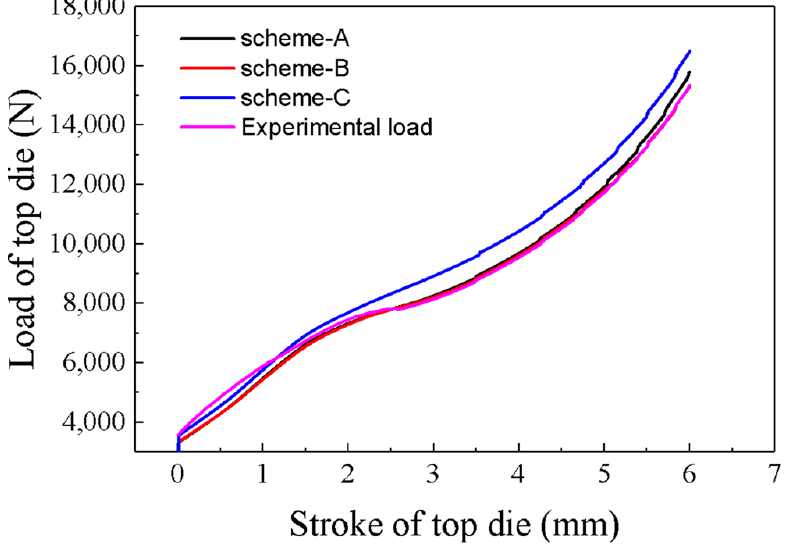
Figure 16. The relationship between the stroke and the loads of top die for these three schemes and experimental values.